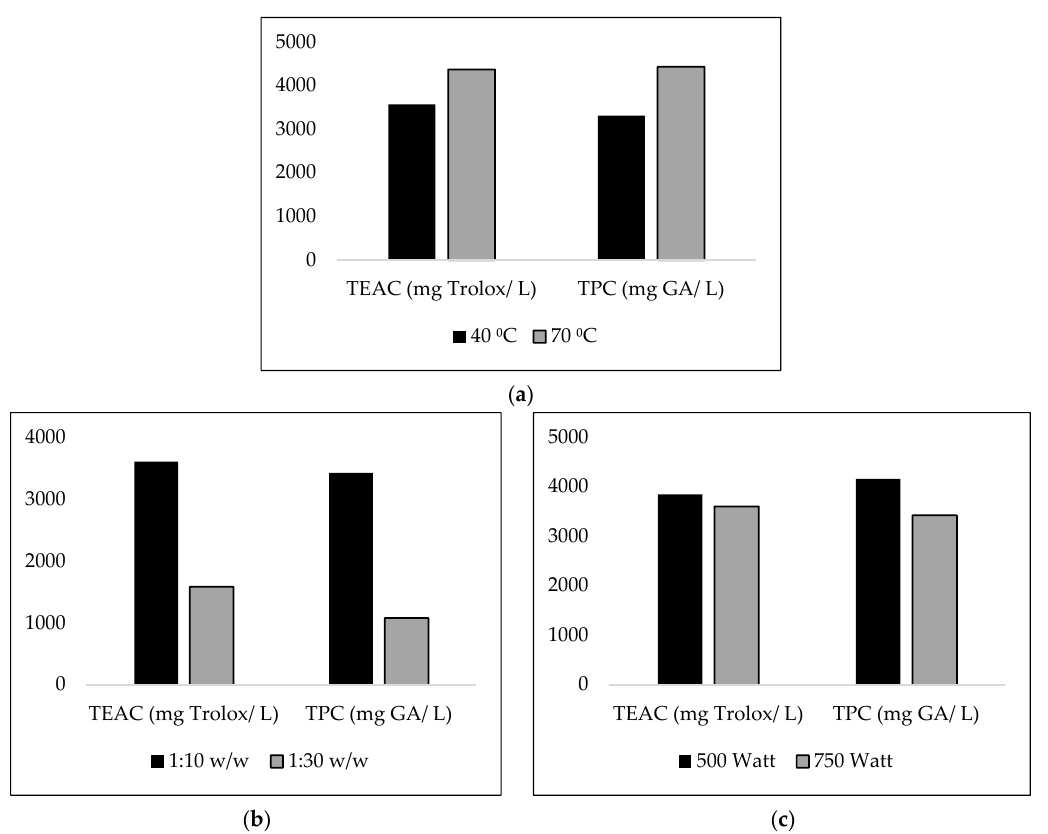
Figure 2. Effect of ( a ) temperature (1:10 w / w , 30 min, 500 Watt), ( b ) biomass to solvent mass ratio (40 °C, 5 min, 750 Watt), and ( c ) irradiation power (1:10 w / w , 40 °C, 5 min) on antioxidant activity (TEAC) and total phenolic content (TPC).